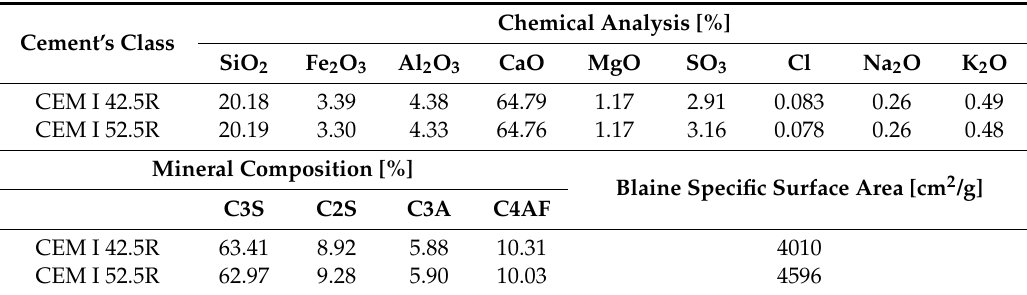
Table 1. Chemical and mineral components and Blaine’s specific surface area of the ordinary Portland cement used in the